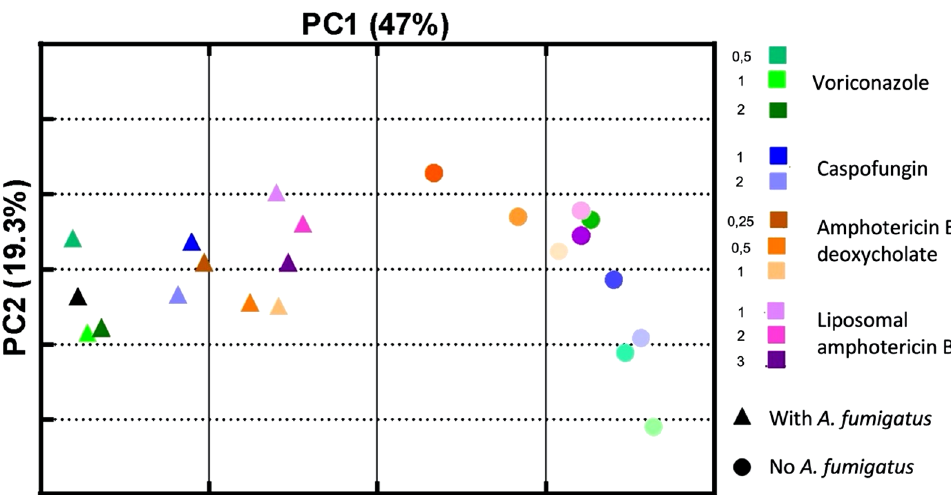
Figure 1. Principal component analysis of the global transcriptomic response for the 84 genes evaluated, across 22 experimental conditions ( Aspergillus fumigatus isolatedly, 11 with antifungals alone, 11 with antifungals + A. fumigatus ). The black triangle represents THP1 cells infected with A. fumigatus , without any